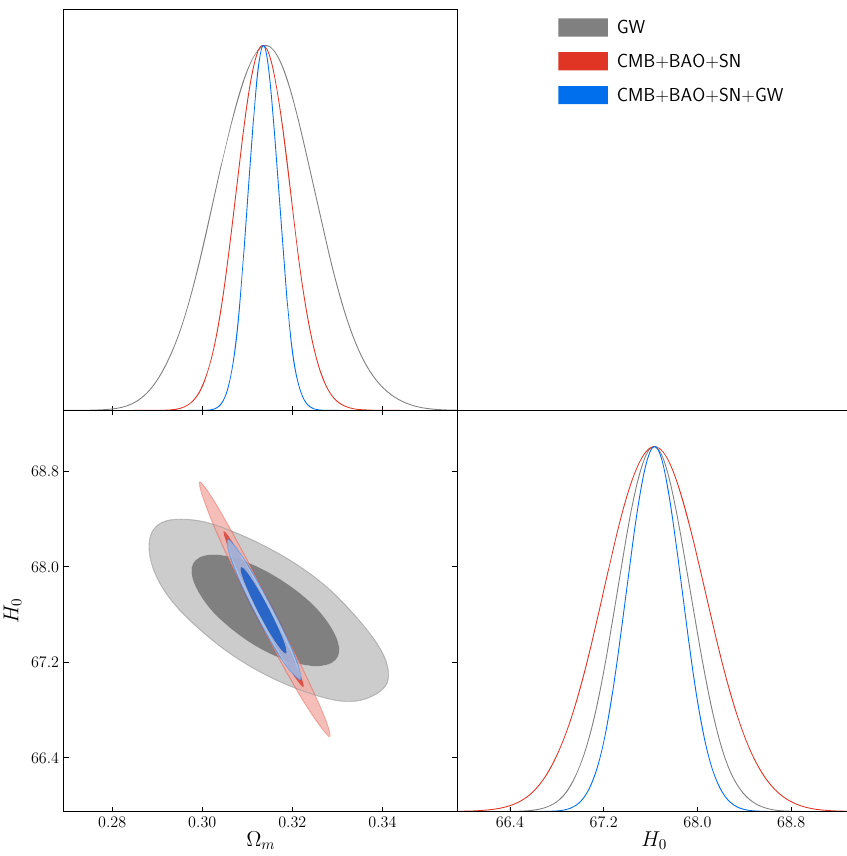
Fig. 1 Observational constraints (68.3% and 95.4% confidence level) on the (cid:3) CDM model by using the GW, CMB + BAO + SN, and CMB + BAO